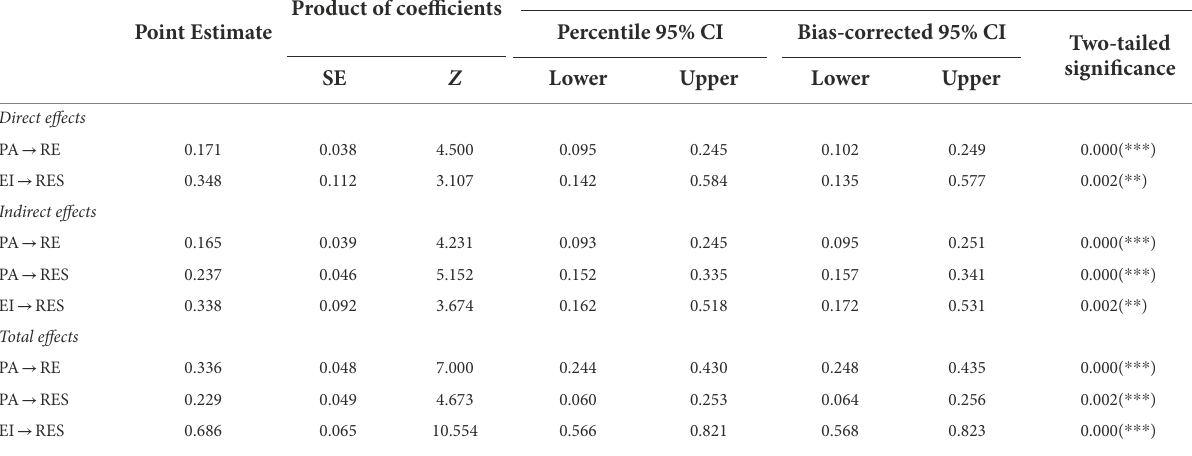
TABLE 4 Standardized direct, indirect, and total